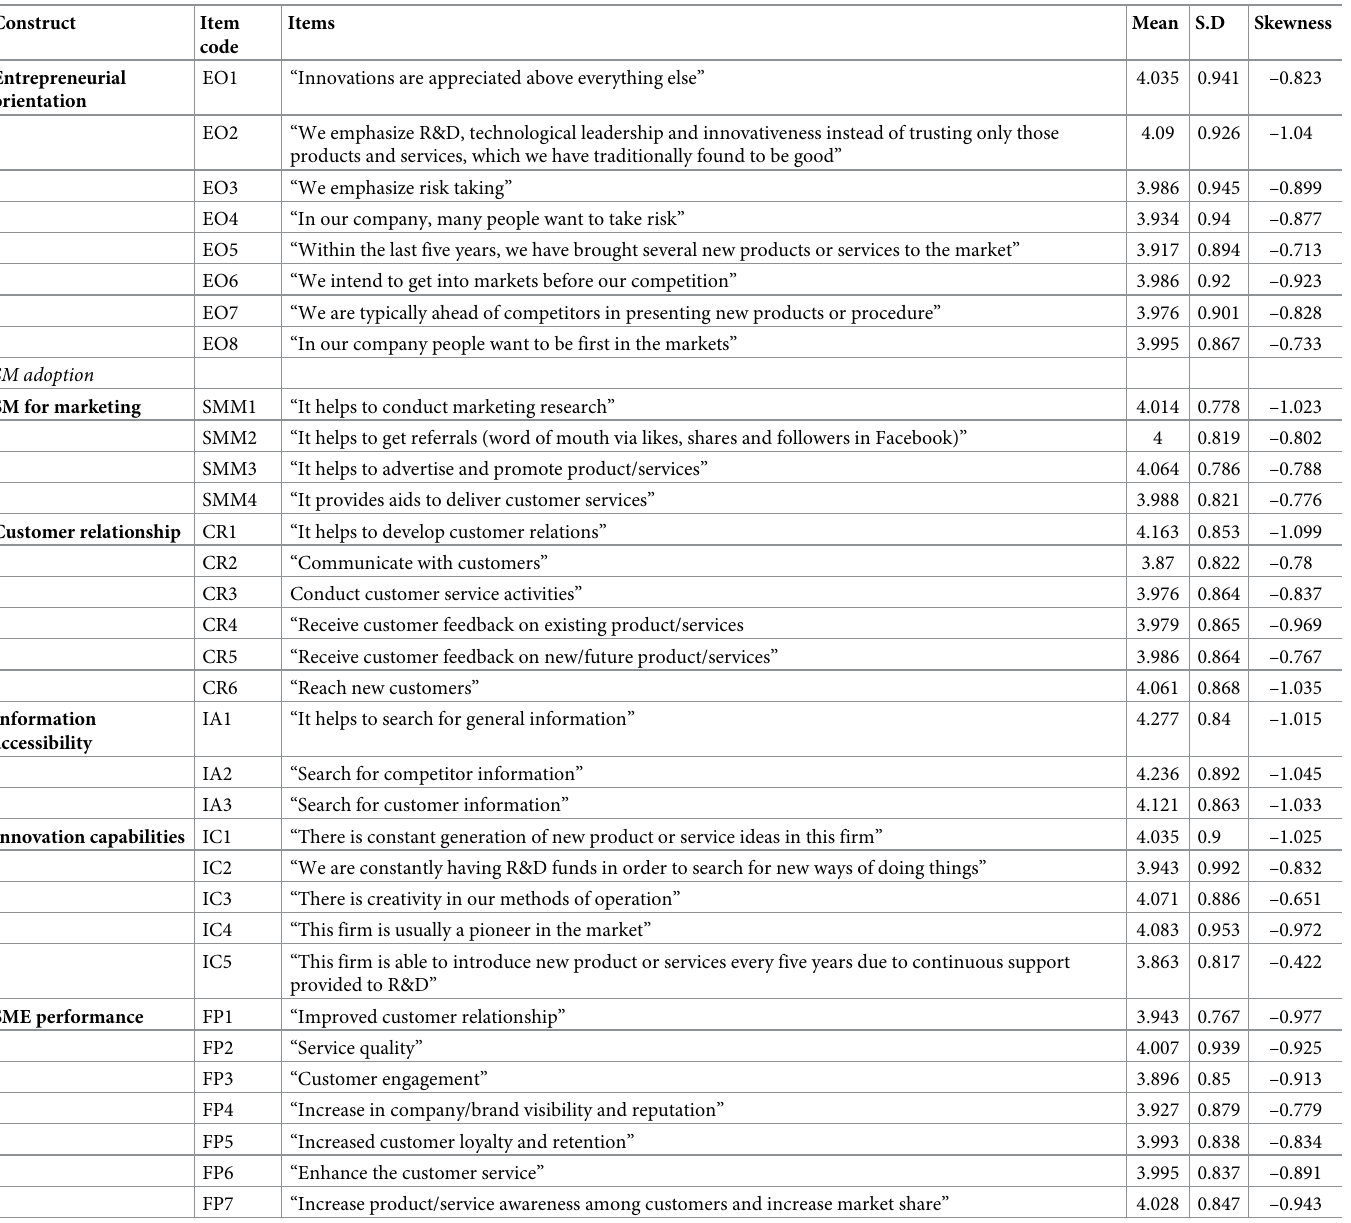
Table 4. Constructs item and descriptive